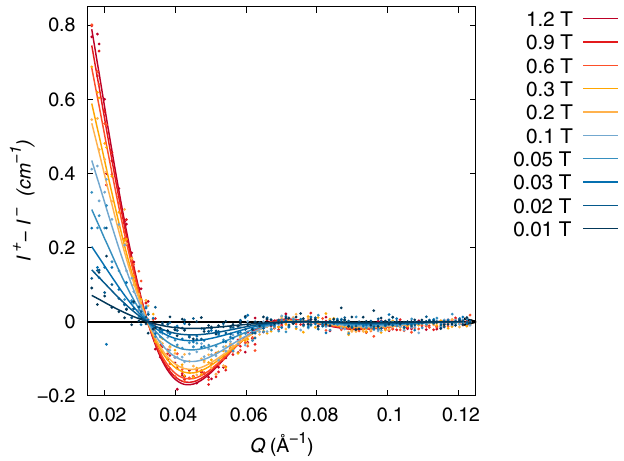
FIG. 14. Fit of the SANSPOL cross term according to micro- magnetic theory.